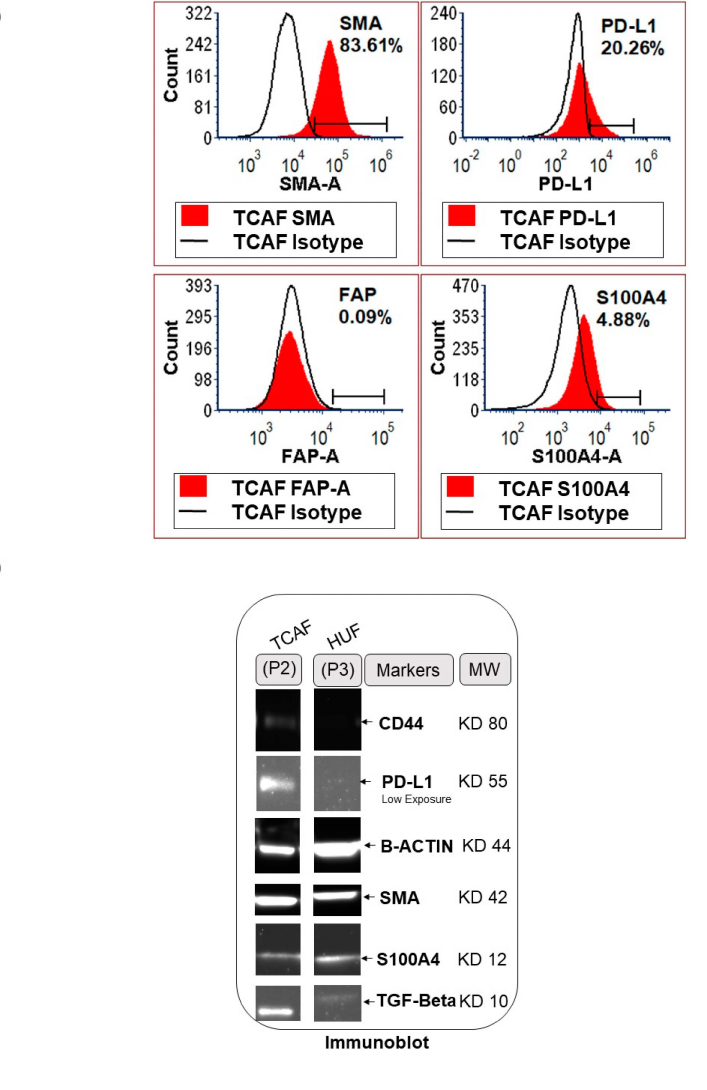
Figure 4. Expression of proteins for CAF markers in the Patient-Derived primary culture of ovar- ian CAF established from the representative tumor sample of ovarian cancers: We tested the expression of protein by flow cytometry for SMA, PD-L1, S100A4, and FAP-A ( A ), and the expression of protein by Western blot for SMA, PD-L1, S100A4, TGFB, and CD44 ( B ) in the Patient-Derived CAFs. B-actin was used as the loading control for the Western